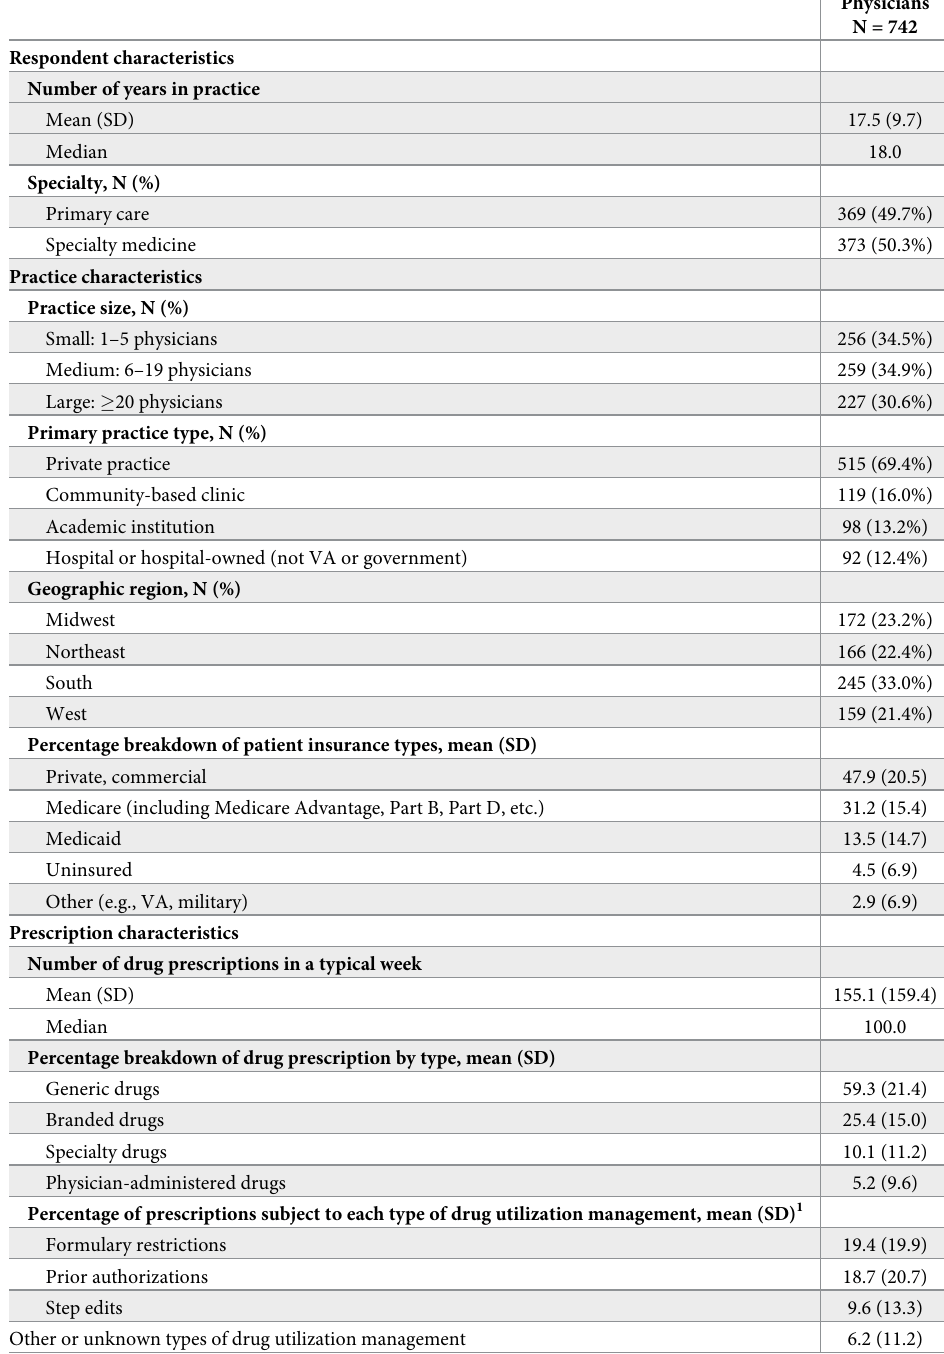
Table 1. Respondent, practice, and prescription